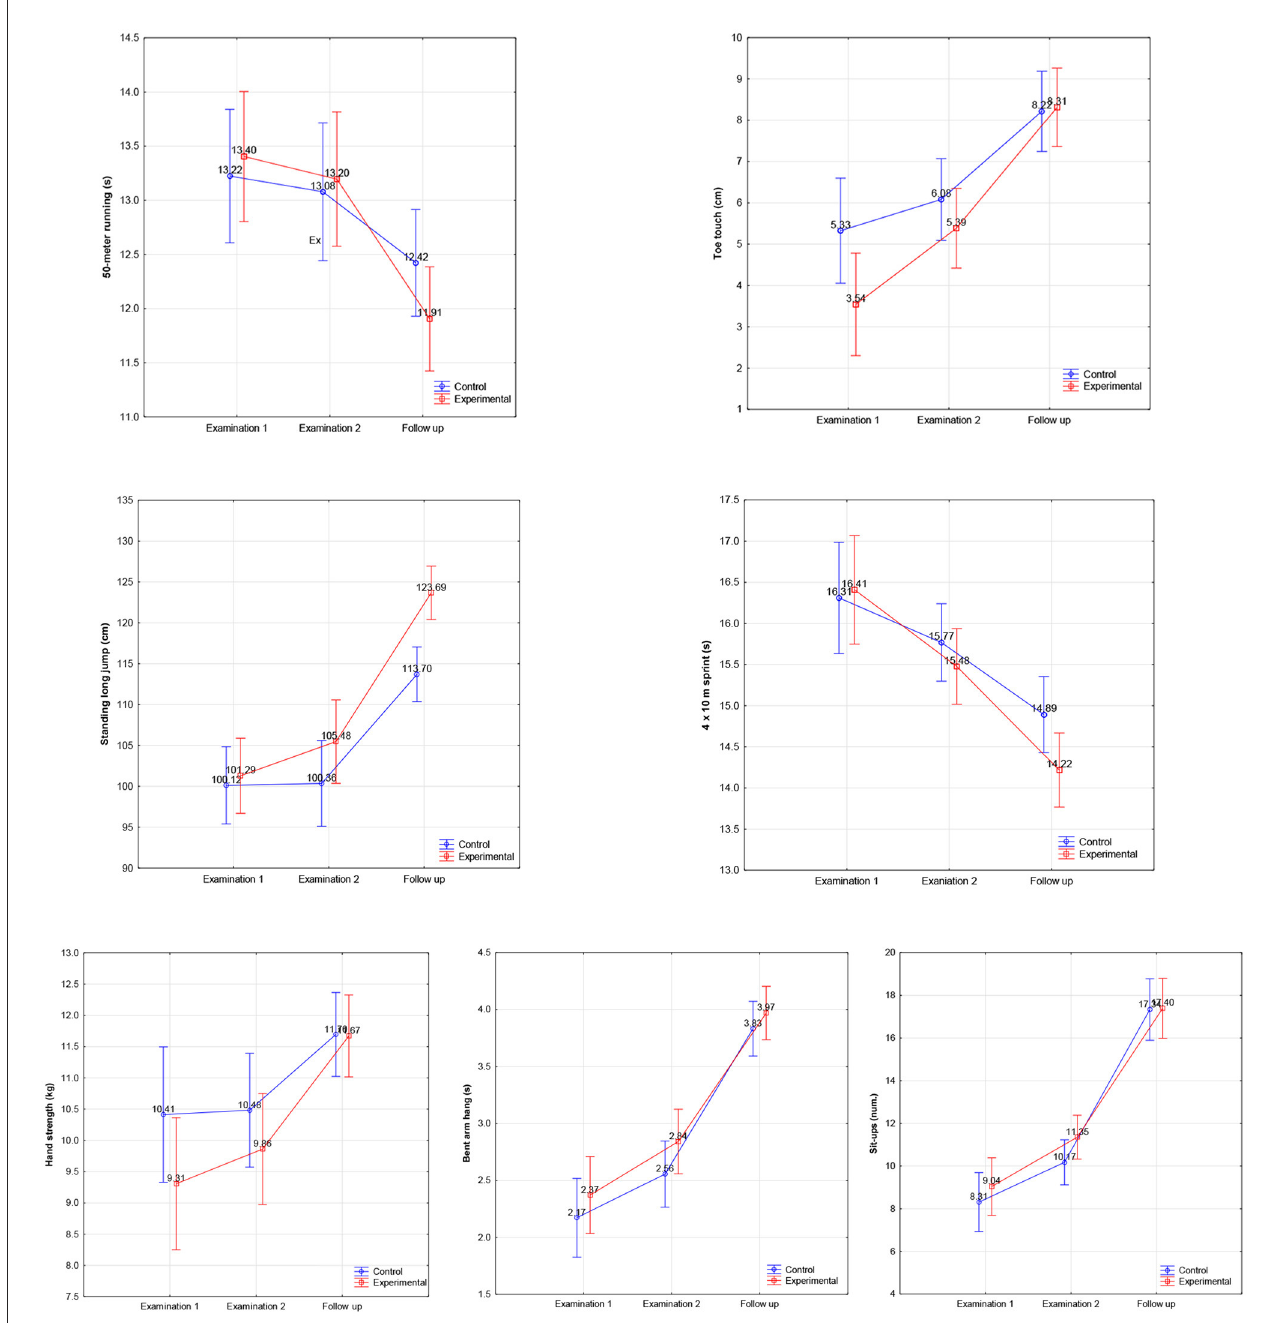
FIGURE1 Physical fitness levels of pupils in the experimental and control groups at the first, second, and follow-up tests.